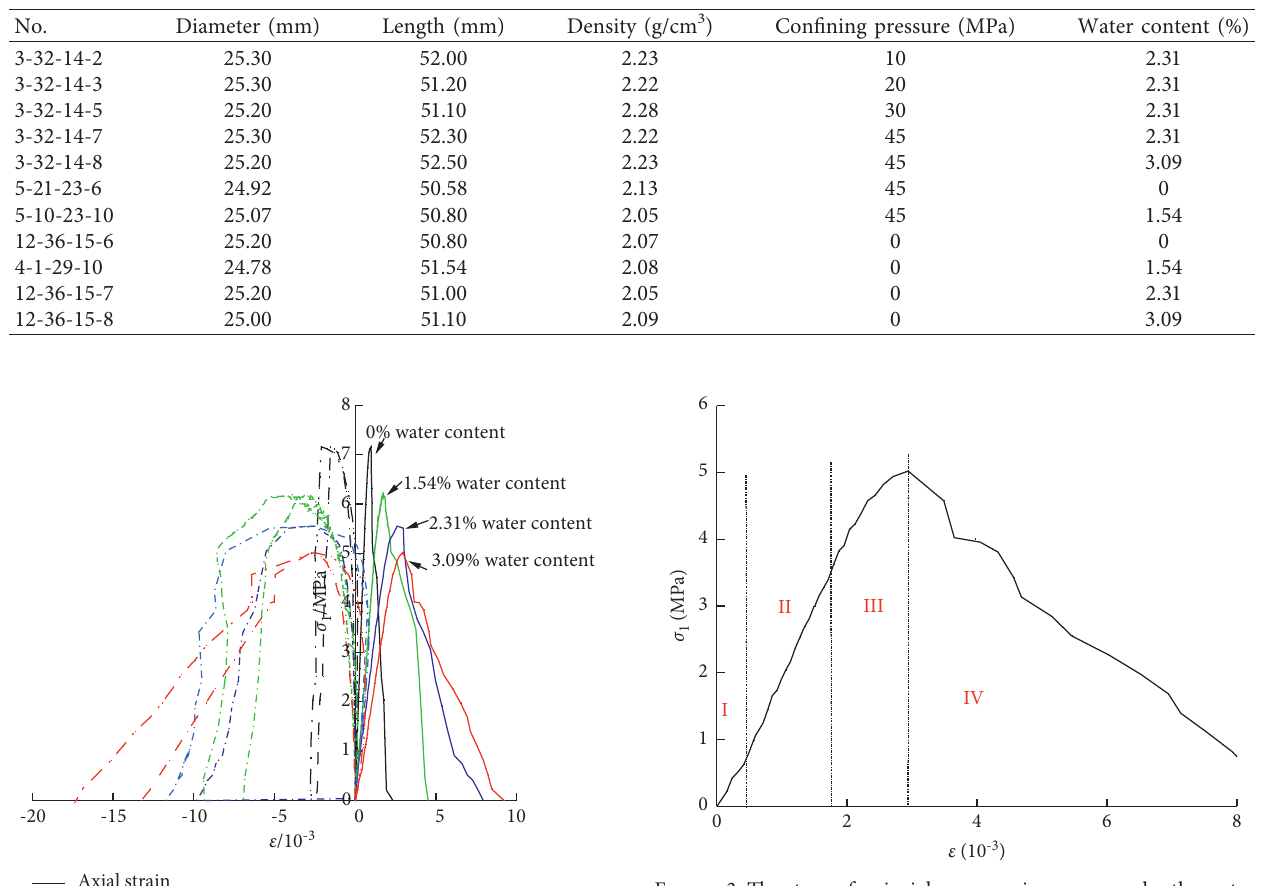
Figure 3: The stage of uniaxial compression curve under the water content of 3.8%.